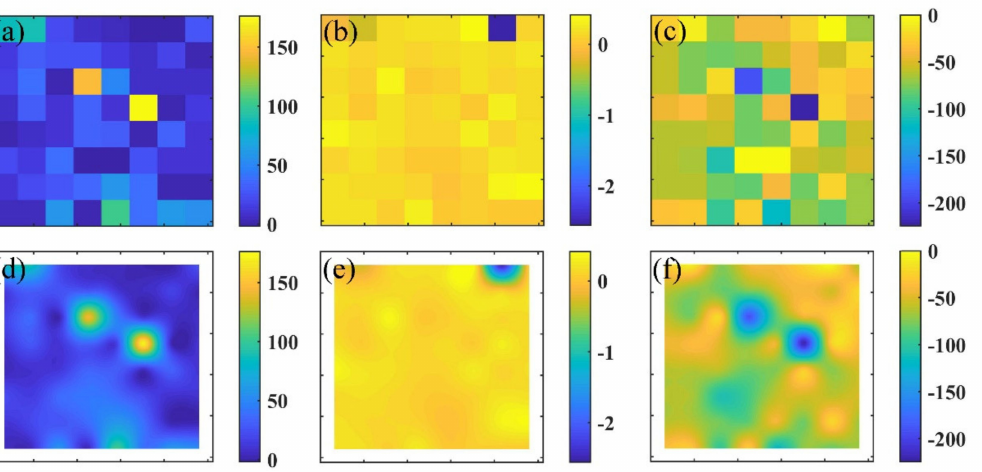
Figure 7. Demonstration of power-law-based SSC method: ( a – c ) show the estimated window- wise scale factor, the power factor, and the offset factor in Equation (3), respectively, and each window is described by a single set of variables; ( d – f ) are parameter maps after spatial interpolation, corresponding to the scale factor, the power factor and the offset factor, from left to right.